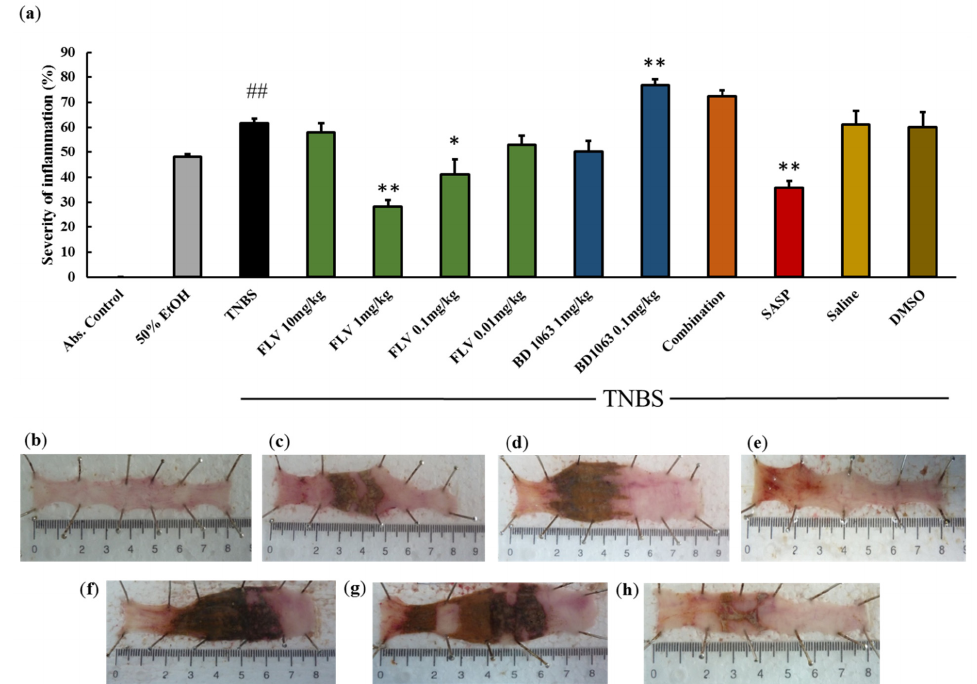
Figure 2. ( a ) Effects of sigma-1 receptor ( σ 1R) on the severity of inflammation in TNBS-induced rat